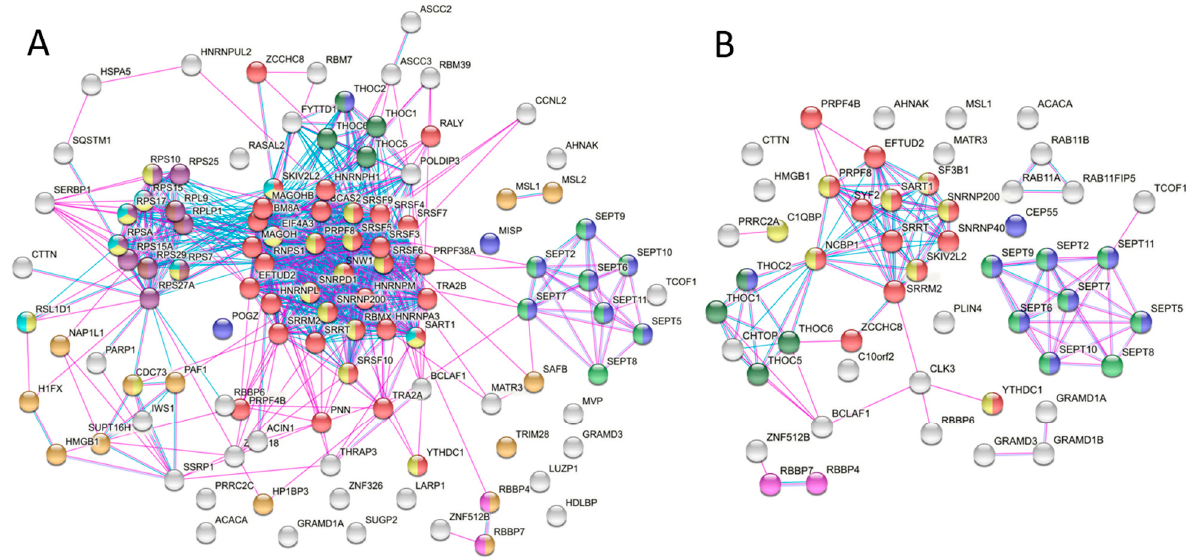
Figure 2. Interaction networks of HMGB1-associated proteins in SKOV-3 ( A ) and PC-3 ( B ) cell lysates showing principal clusters. Colour code is as follows: red, mRNA splicing, via spliceosome (GO:0000398); dark blue, rRNA processing (GO:0006364); green, ribonucleo-protein complex biogenesis (GO:0022613); yellow, nuclear transport (GO:0051169); pink, chromatin organisation (GO:0006325); purple cell division (GO:0051301); brown, DNA repair (GO:0006281); dark green, NuRD complex (GO:0016581).